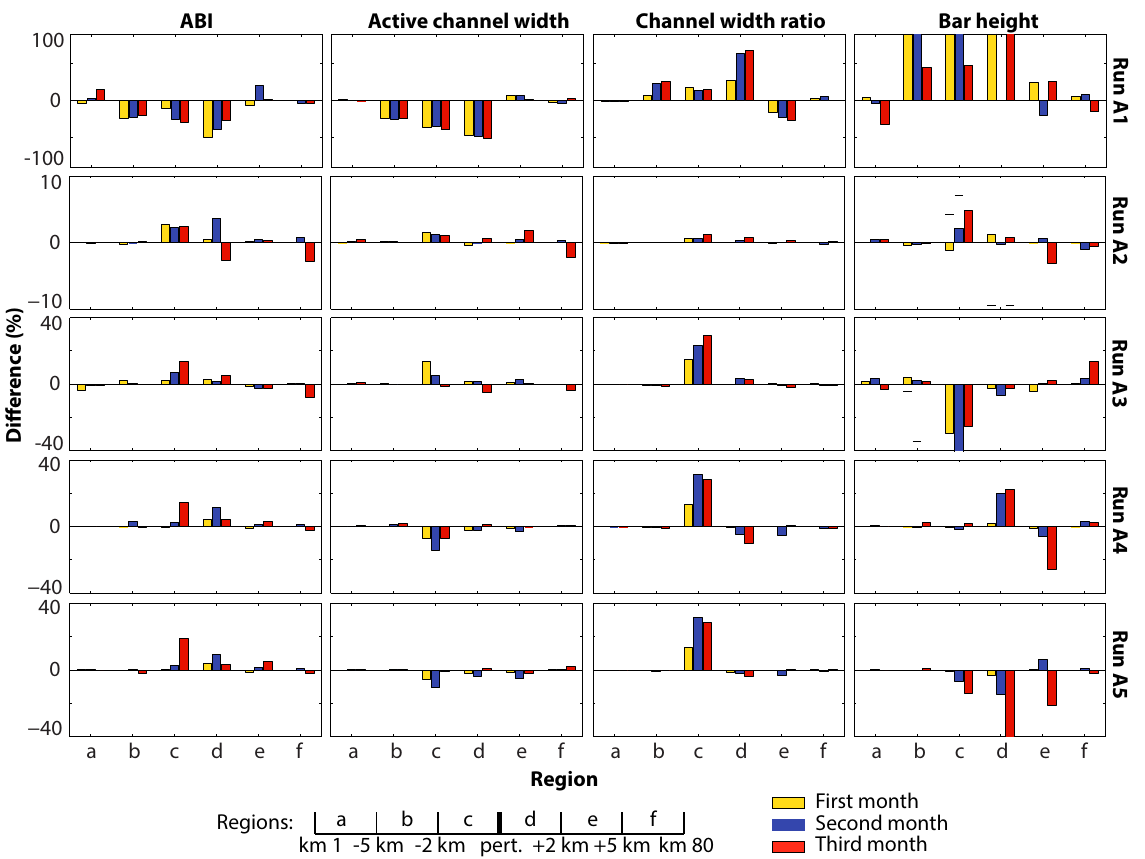
Figure 14. Difference in bar pattern statistics between Run A0 and Runs A1 to A5. The metrics are averages over time: averaged over first month (yellow), second month (blue), and third month (red), and averages over regions. The boundaries of these regions are defined at specific distances from the disturbance (“pert.”).